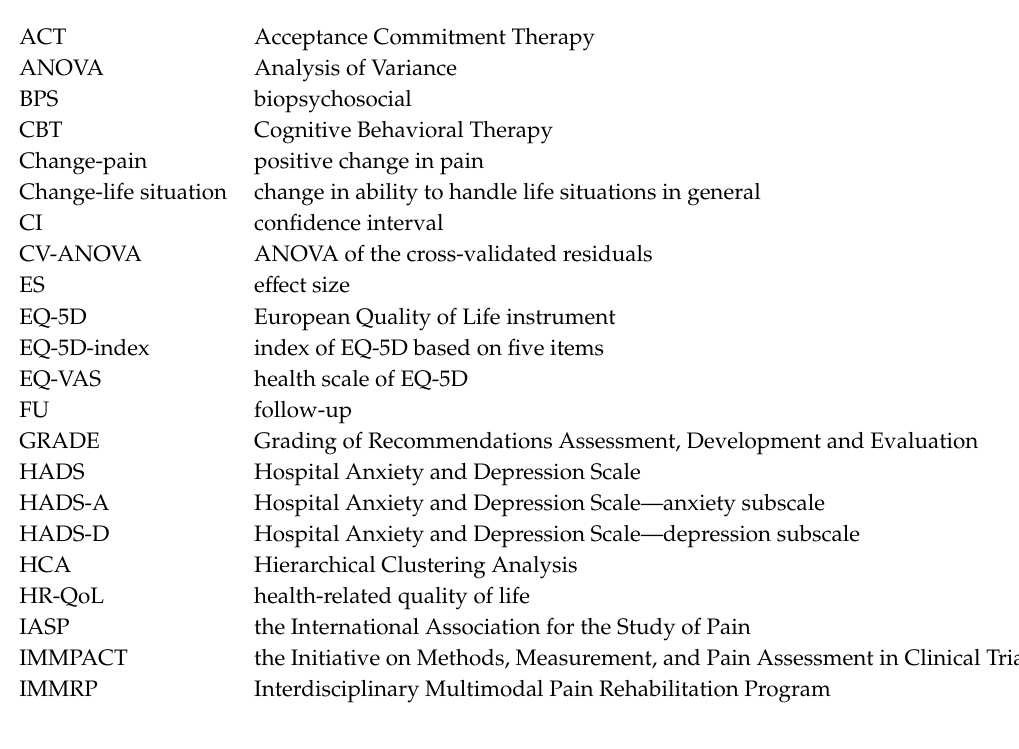
Table S1: Pre-IMMRP situation for patients reporting their outcomes at 12-m FU and those not reporting their outcomes at 12-m FU, Table S2: OPLS regressions of MIS at post IMMRP in the three clusters, Table S3: OPLS regressions of MIS at 12-month FU in the three